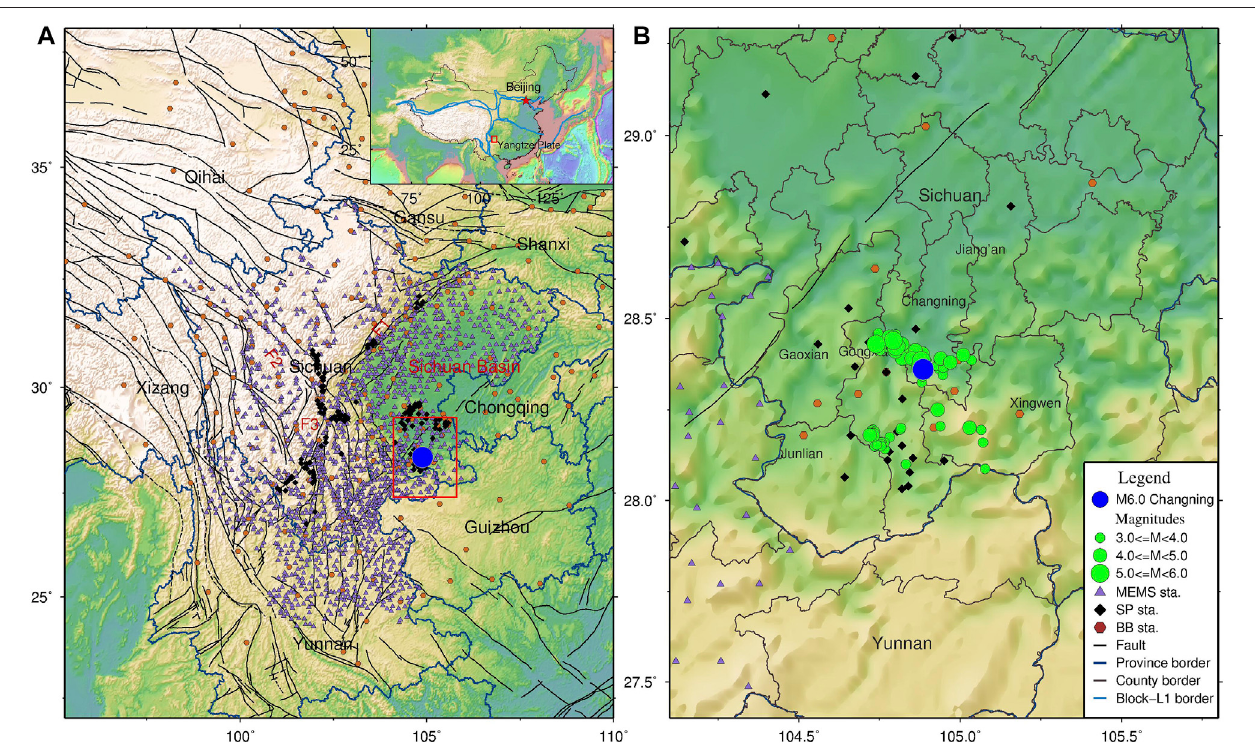
FIGURE1|(A) Station distributionofthecurrentlyused SichuanSeismicNetwork(March31,2021).F1, F2,and F3aretheLongmenshan,Xishuihe,and Xiaojiang fault zones, respectively. (B) Station distribution in the area around the Changning seismic sequence for the fi rst stage. Purple triangles, black diamonds and brown hexagons represent MEMS-based stations, short period seismic stations and broadband seismic stations, respectively. The blue circle shows the epicenter of the June 17,2019 M 6.0Changningearthquake.Alargemapwiththemarkedstudiedareaisshownintheinset.Greencirclesindicatetheearthquakeswith M 3.0ormorein the Changning seismic sequence, and their sizes are proportional to their magnitudes. Black lines are faults presented by Deng et al. (2003).